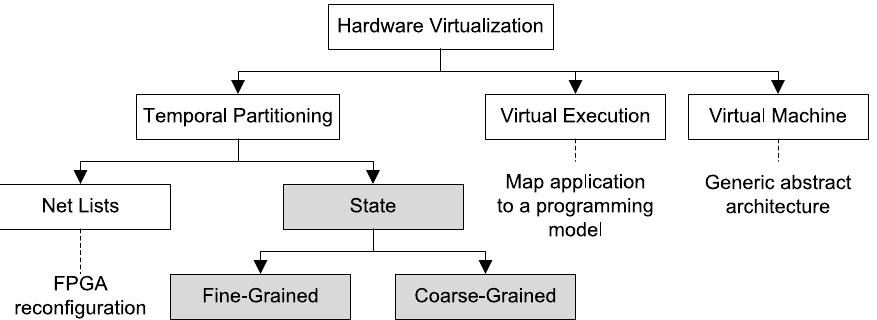
Figure 2. Hardware virtualization approaches. White boxes are described by Plessl and Platzner [11]. Gray boxes are described by Chuang